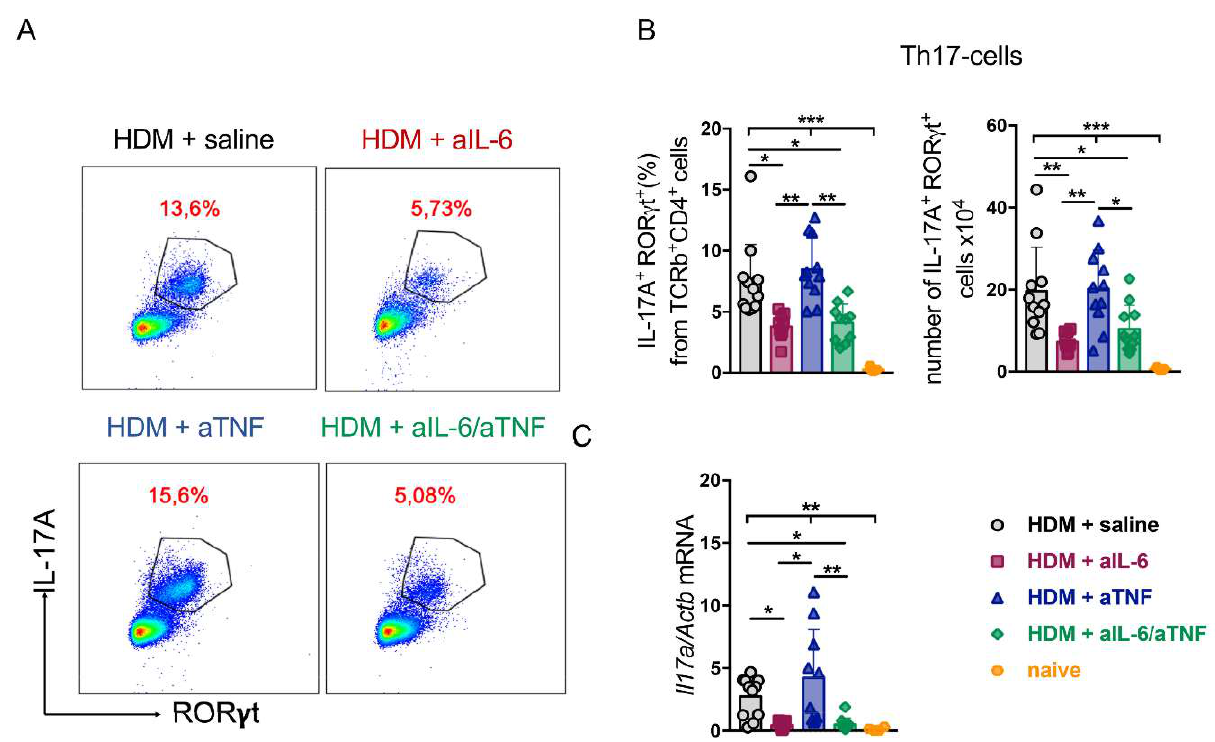
Figure 3. Th17-cell response in HDM-treated mice with combined anti-TNF/IL-6 treatment. Representative FACS plots ( A ) and frequency (%) ( B ) of IL-17A + RORγt + cells gated on TCRb + CD4 + live cells in the lungs of control mice and mice with anti-cytokine treatment. ( C ) Relative expression of Il17a gene normalized to Actb by quantitative RT-PCR analysis in the lungs 48 h after last HDM challenge. Each point in a diagram represents a single mouse (5–12 mice in each group); mean ± SD. One-way ANOVA test revealed: * p < 0.05; ** p < 0.01; *** p < 0.001.